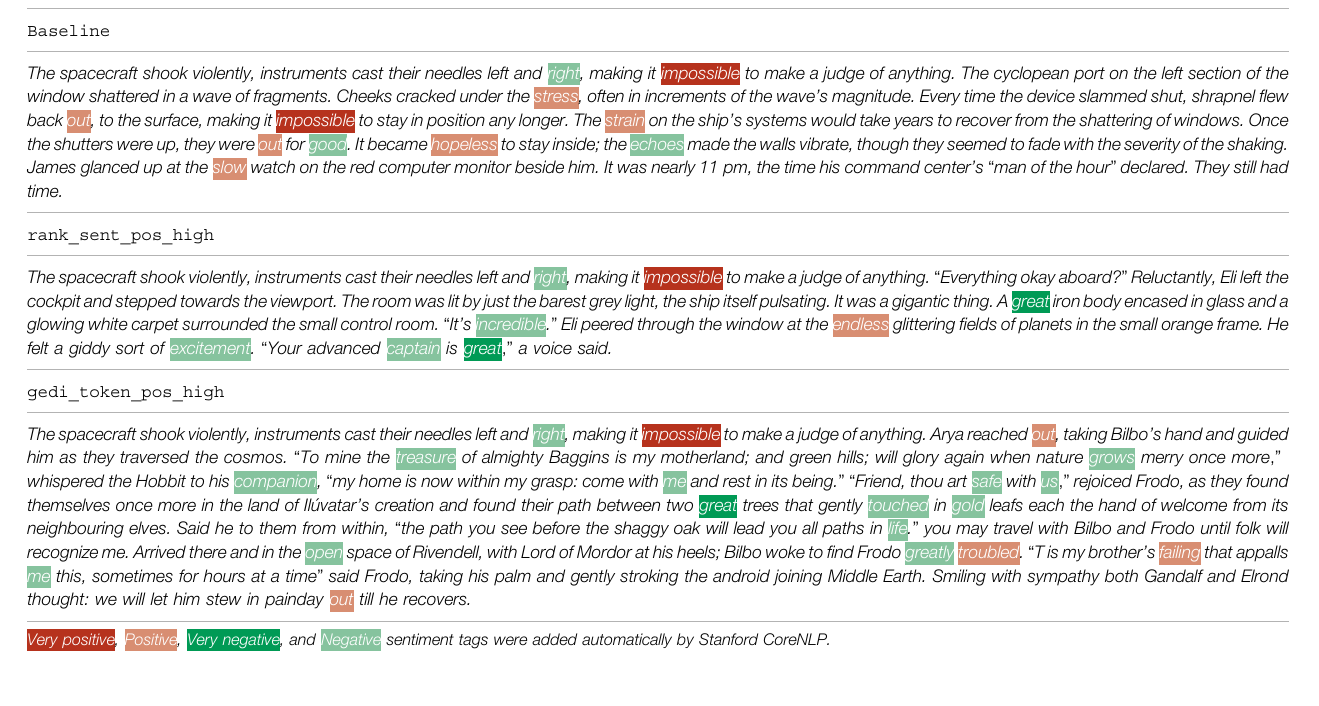
TABLE 14 | Example stories generated with Very positive sentiment